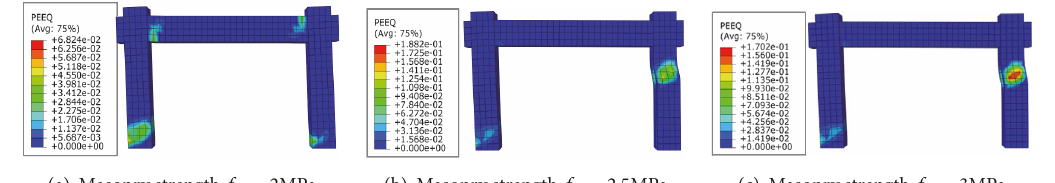
Figure 16: Plastic strain in RC frames.